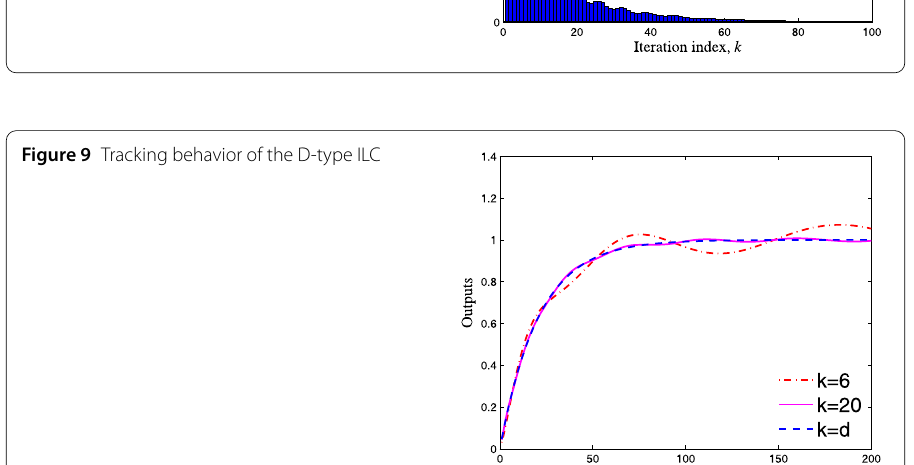
Figure 9 Tracking behavior of the D-type